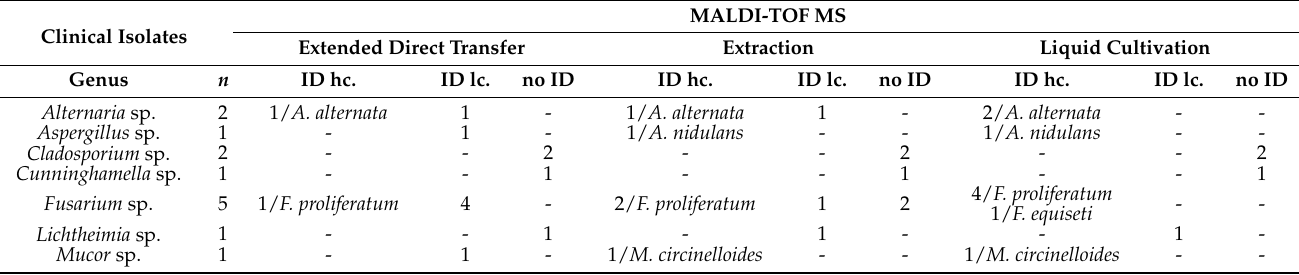
Table 4. Isolates identified at the genus level and included in the Filamentous Fungi Library 3.0 ( n = 23). Results of the MALDI-TOF MS using three different sample preparation procedures. Interpretation of results, i.e., identification with high confidence (at the species level) or with low confidence (at the genus level), according to the manufacturer’s recommendations. Abbreviations: